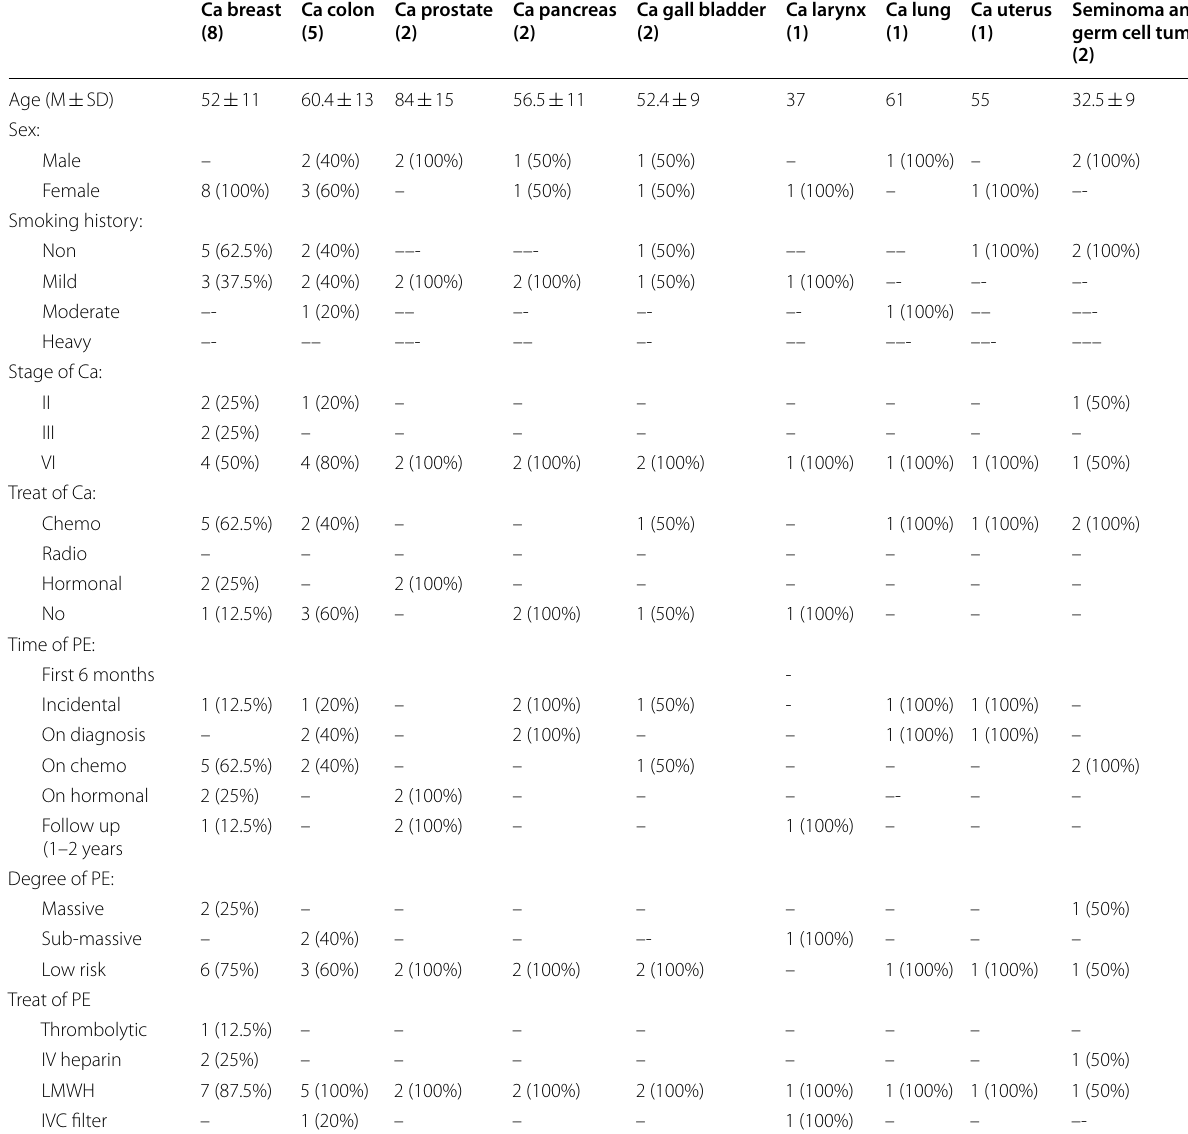
Table 2 The demographic data and characters of PE in different types of cancers